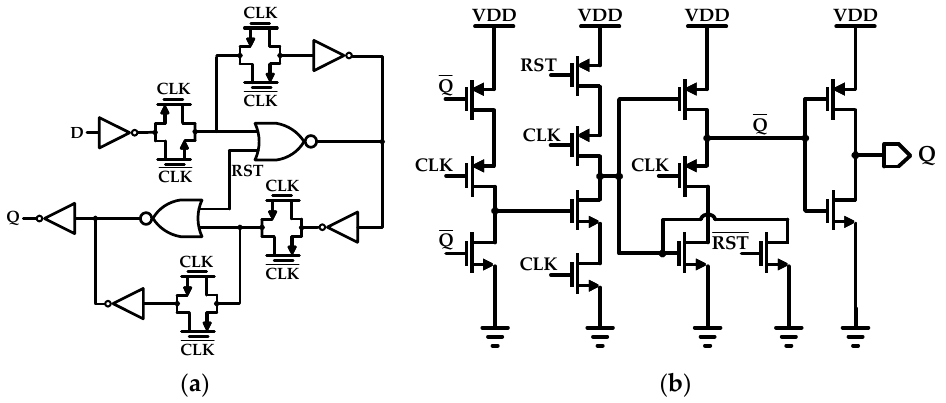
Figure 7. ( a ) Circuit of the conventional DFF; ( b ) Circuit of TSPC DFF.